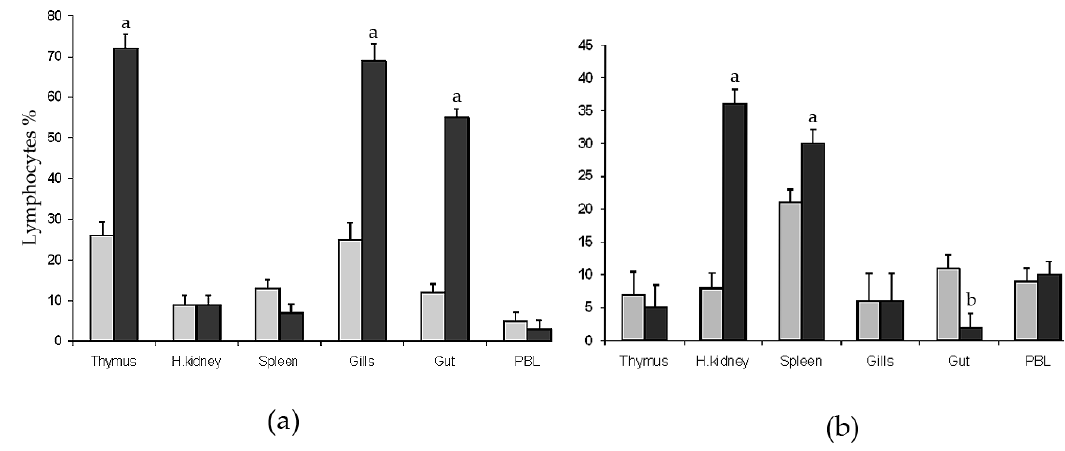
Figure 1. Flow cytometry analysis of ( a ) T-cells (DLT15+) and ( b ) B-cells (DLIg3+) in different tissues (thymus, head kidney, spleen, gills, gut, and peripheral blood) of sea bass specimens exposed to two different levels of water oxygenation: 6 ± 1 mg L − 1 (sub-optimal; light grey columns) and 13 ± 1 mg L − 1 (hyper-oxygenated; black columns). Significantly different from the normal oxygenated group a p < 0.01; b p < 0.05. Table 1. Immuno ‐ histochemistry results. Cellular density ( N cells/mm 2 ) of DLT15+ and DLIg3+ lymphocytes (T ‐ and B ‐ cells, respectively) in lymphoid tissues of sea bass reared under sub ‐ optimal water oxygen (6 mg/L, NO group) or hyper ‐ oxygenation (13 mg/L, HO group).